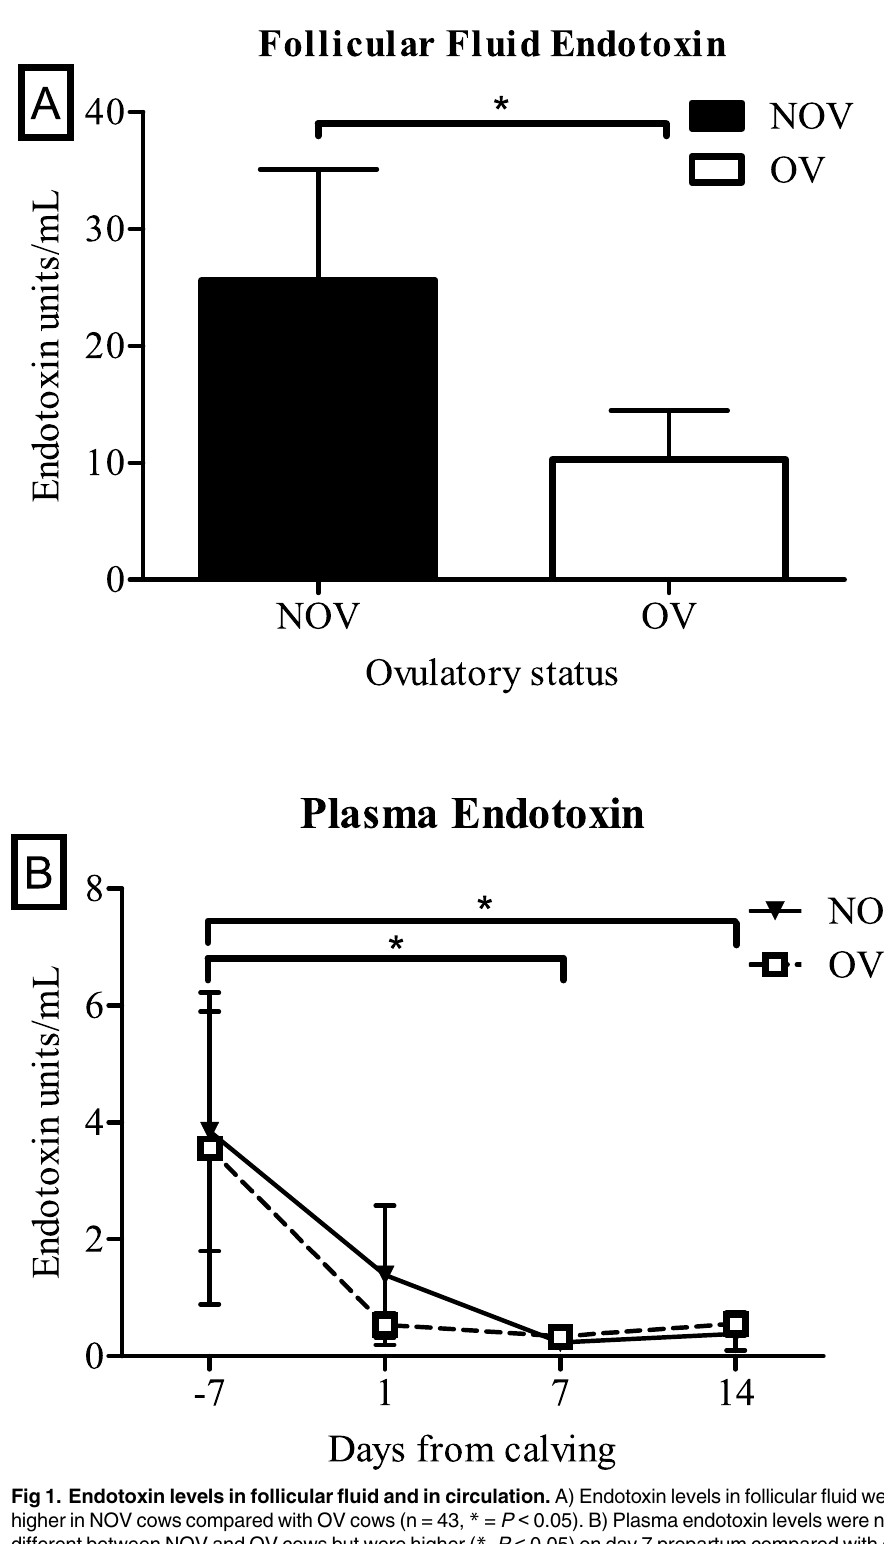
PLOS ONE | https://doi.org/10.1371/journal.pone.0177356 May 19,